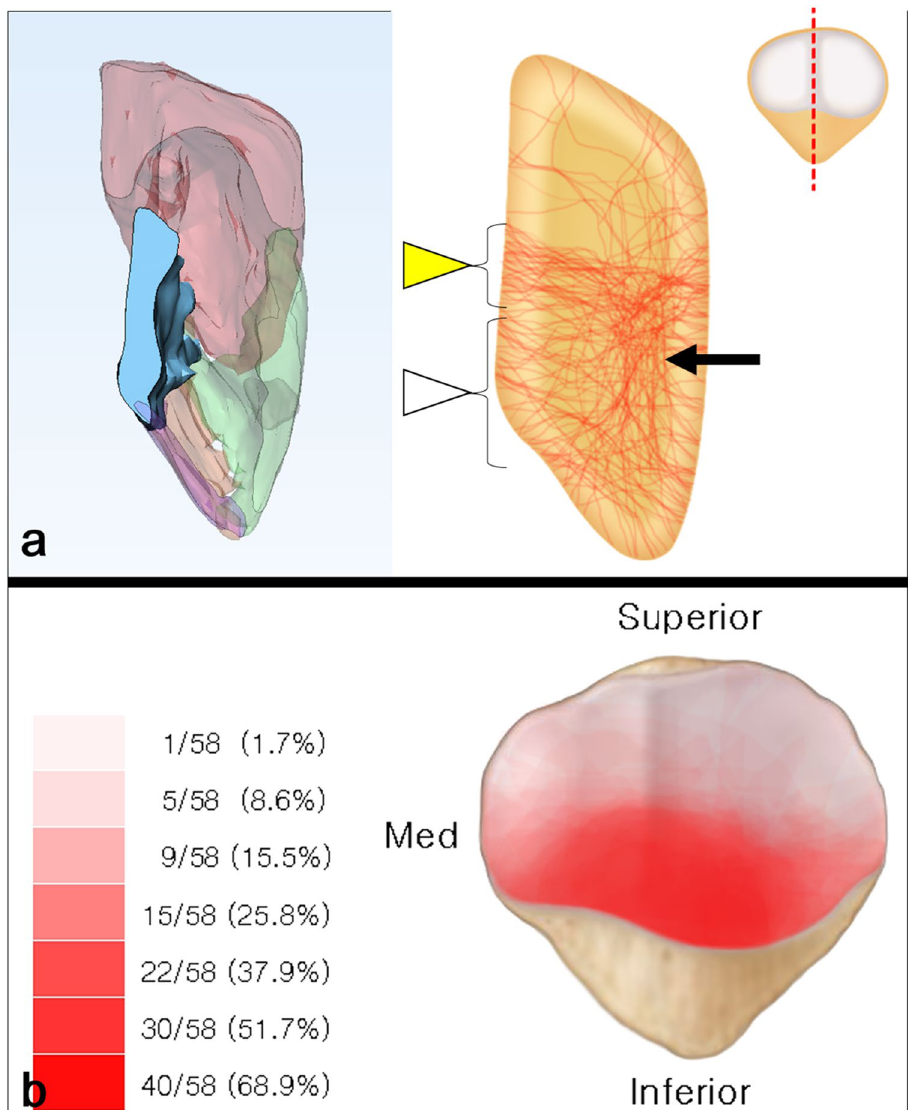
Figure 7. Midsagittal fracture mapping showing an X-shaped fracture pattern made of primary horizontal fracture lines (yellow arrow), secondary fracture lines (white arrow), and main coronal fracture lines (black arrow). By linking these fracture lines, the coronal split fragment can be developed ( a ). This picture shows the distribution of the coronal split fragment. The major zone of the coronal split fragment was the inferior facet of the lateral and medial facets ( b